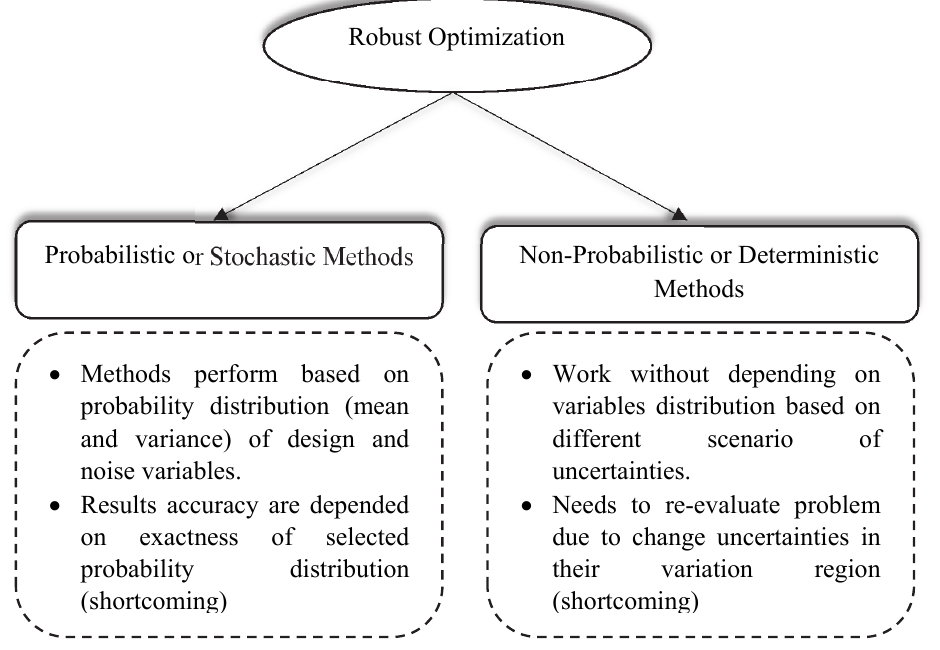
Fig. 4. Classification of robust optimization